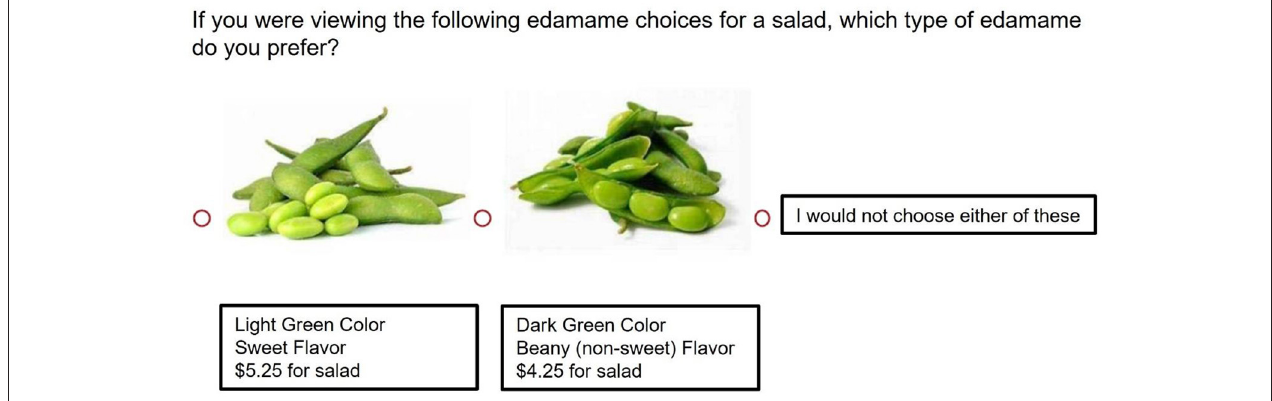
FIGURE 1 | Example of a choice question answered by consumers in the choice-based conjoint analysis to determine their willingness-to-pay (WTP) for edamame